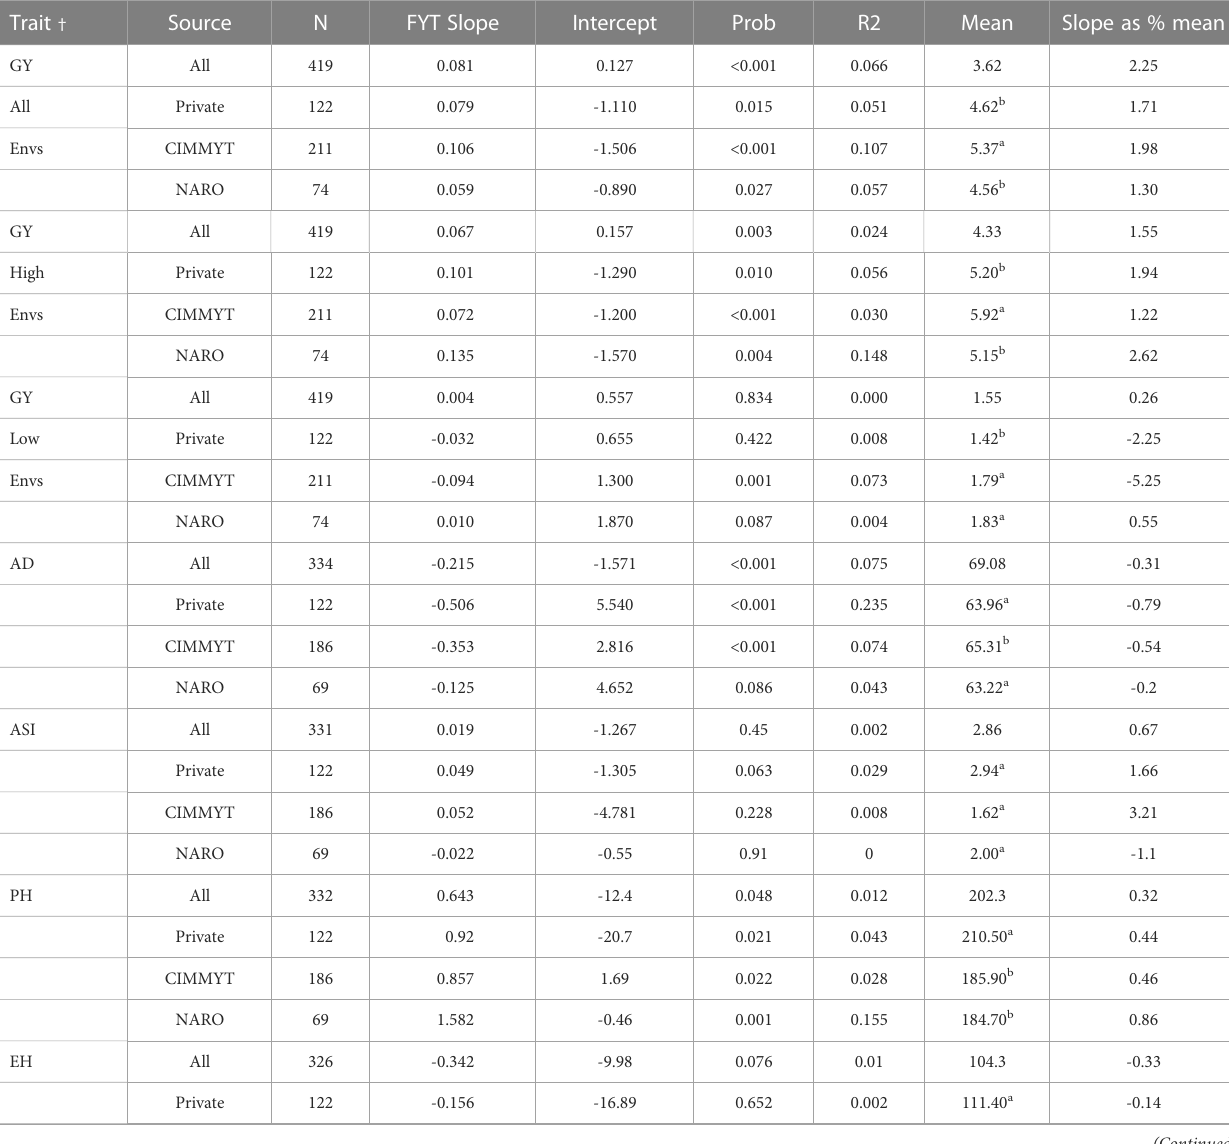
TABLE 6 Results from regression of the Best Linear Unbiased Estimators (BLUEs) for grain yield and other agronomic traits of entries in the National Performance Trials (NPTs) by source onto their fi rst year of testing (FYT). Trait